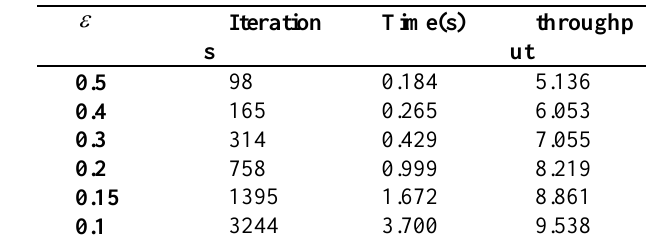
Table 1.The change of